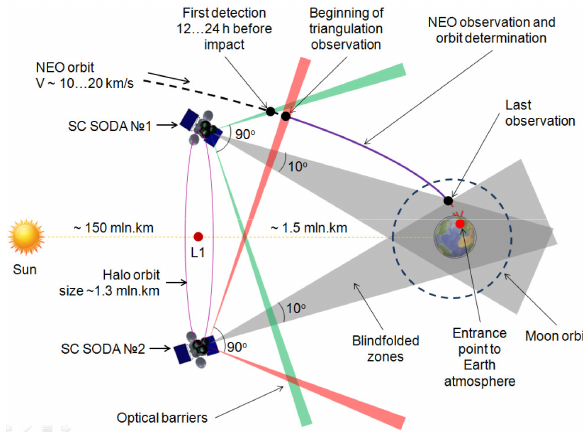
Figure 2. Scheme of observation in SODA project: a view at X-Y pro- jection, seen from ecliptic pole. Table 1. Typical operational parameters of SODA project.